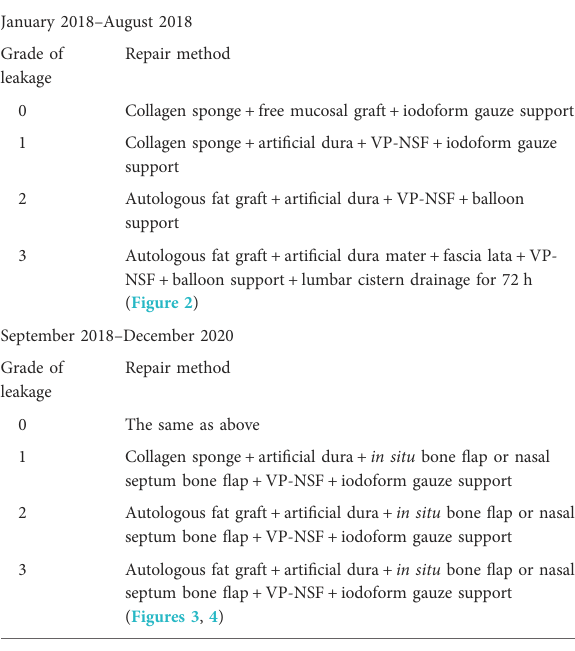
( Figure 5A ), seven cases with breached inner arti fi cial dura, three cases with VP-NSF displacement, two cases with VP- NSF inactivation ( Figure 5B ), two cases with VP-NSF perforation, and one case with imperfect adherence of VP- NSF to the skull base ( Table 2 ).